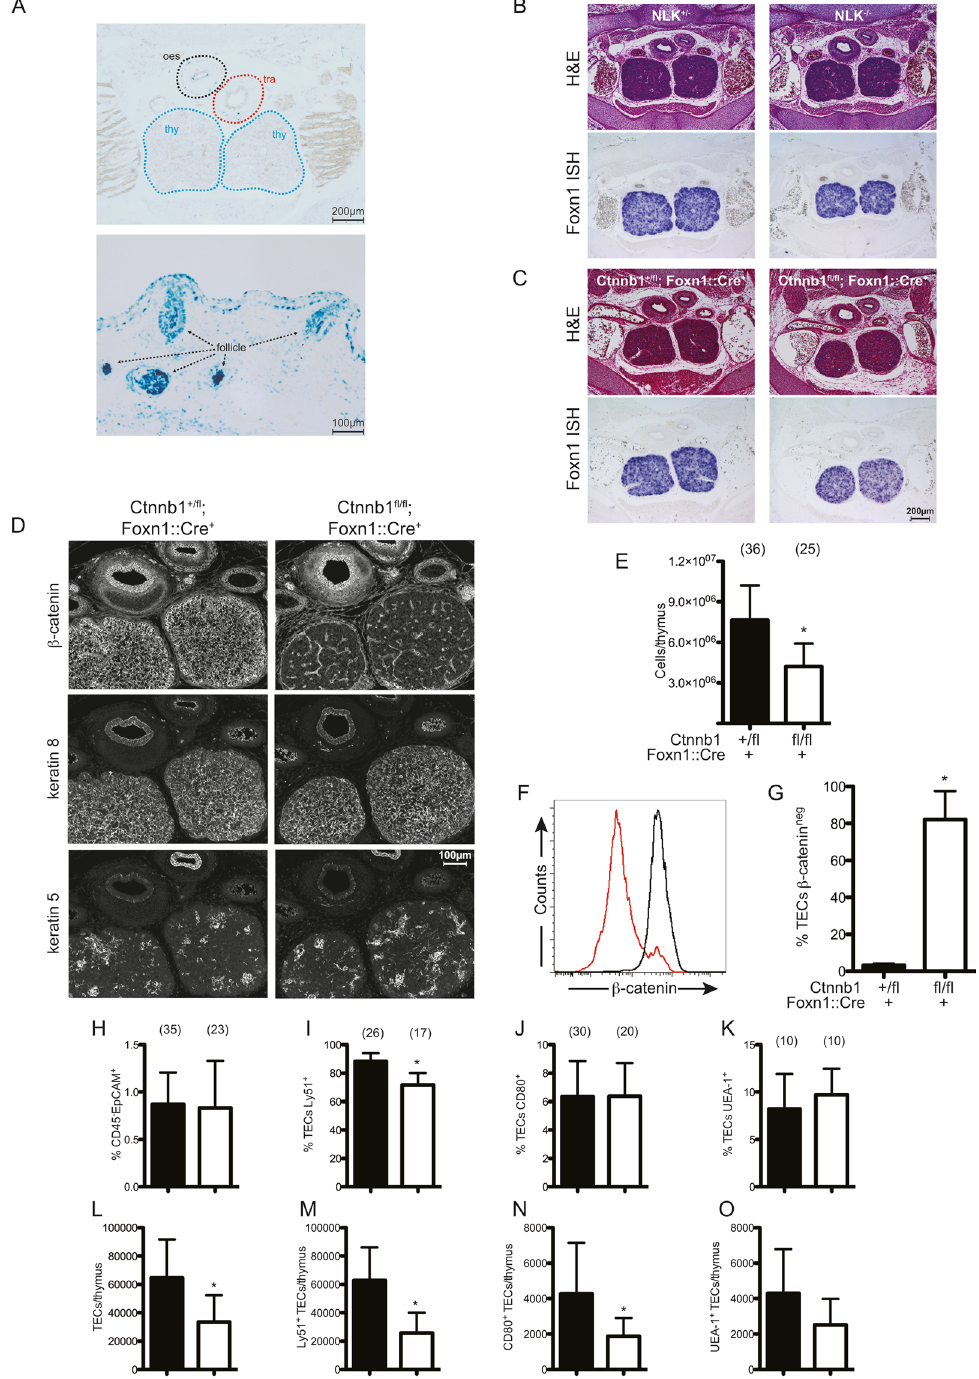
Figure 1. Thymus development in Nlk - and Ctnnb1 -deficient mice. ( A ) X-Gal staining of E15.5 BATgal- transgenic thymus (upper panel) and whisker follicles (lower panel). ( B , C ) Thymus sections stained with H&E (top panels), or subjected to Foxn1 RNA in situ hybridization (ISH) (bottom panels). ( D ) Immunofluorescence (IF) analysis of thymus sections with antibodies against β -catenin, K8 and K5 for the indicated genotypes. E15.5 embryos of the indicated genotypes are shown in ( B – D ). Scale bars are indicated. ( E ) Total thymocyte cell counts. ( F ) Intra-cellular staining for β -catenin expressed by gated CD45 − EpCAM + TECs (Control TECs, black, Ctnnb1- deficient TECs, red). ( G ) Percentage of β -catenin-negative TECs. ( H and L ) Proportions ( H ) and total numbers ( L ) of EpCAM + TECs. (I&M) Proportions ( I ) and total numbers ( M ) of Ly51 + TECs. (J&N) Proportions ( J ) and total numbers ( N ) of CD80 + TECs. (K&O) Proportions ( K ) and total numbers ( O ) of UEA- 1 + TECs. Analyses of TECs from newborn control (black columns) and Ctnnb1- deficient (open columns) mice are shown in ( E – O ). Bar graphs are presented as mean ±